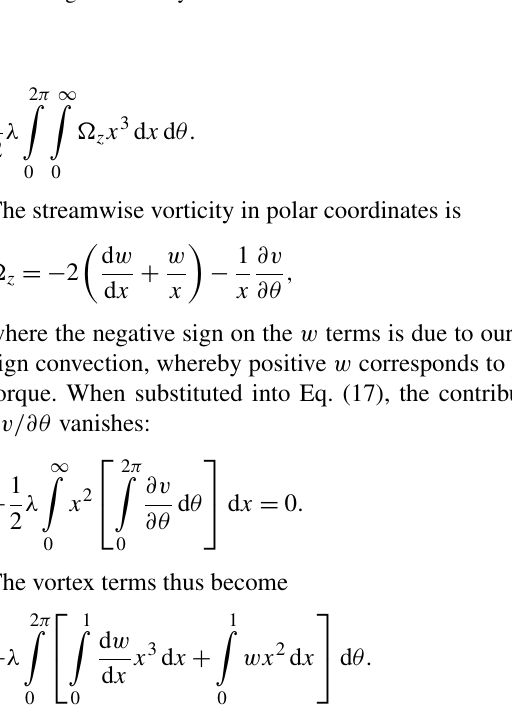
Figure 2. Velocity (in the rotating frame of reference) and vorticity vectors in the near wake. If diffusion is neglected and the wake is assumed to be rigid, velocity and vorticity triangles on each orthogonal plane are geometrically